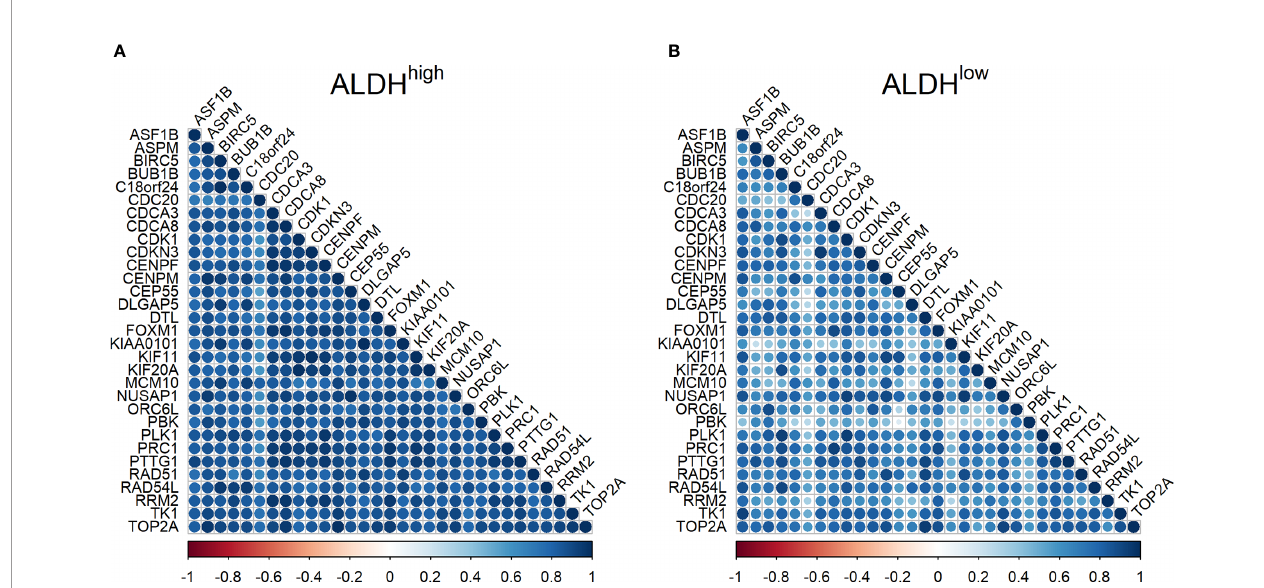
FIGURE 1 | Correlation between mRNA expression of target genes in ALDH high and ALDH low cells in non-small cell lung cancer. (A) correlation in ALDH high cells; (B) correlation in ALDH low cells. The Spearman ’ s correlation coef fi cient for Ct values is reported for each pair of target genes by using a circle. The color and the diameter of the circles are proportional to the intensity of the correlations, as reported in the color palette. Blue indicates a highly positive correlation, white indicates no correlation, and red indicates a highly negative